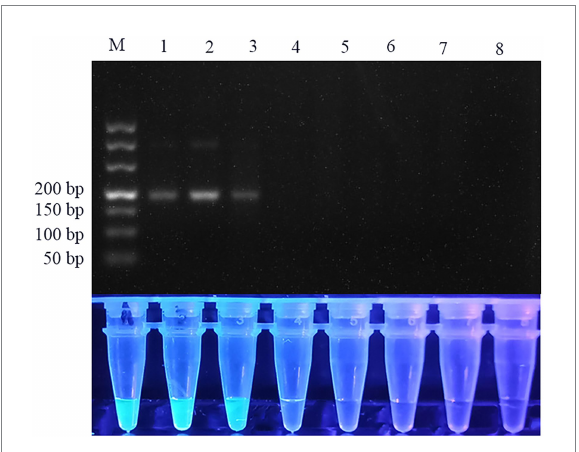
FIGURE 5 Specificity of RPA assay. Lane 1: Anisakis simplex ; lane 2: Anisakis pegreffi i; lane 3: Anisakis typica ; lane 4: Hysterothylacium aduncum ; lane 5: Ligula intestinalis ; lane 6: Trichirurus lepturus tissue; lane 7: Larimichthys polyactis tissue; lane 8: ddH 2 O. Top row: agarose gel electrophoresis images of RPA reactions. Bottom row: Fluorescent assay images corresponding to the RPA reactions.